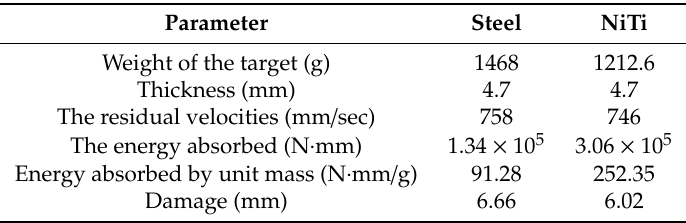
Table 4. Comparison between steel and NiTi shape memory alloy plate.